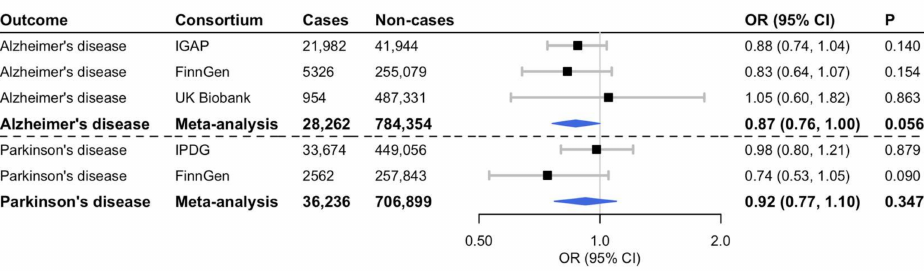
Figure 1. Associations between genetically predicted higher plasma caffeine levels and risk of Alzheimer’s and Parkinson’s disease. CI, confidence interval; OR, odds ratio. Cochran’s Q test statistic for heterogeneity between study-specific estimates: Q = 0.59 ( p = 0.74) for Alzheimer’s disease and Q = 1.73 ( p = 0.19) for Parkinson’s disease. The blue diamonds represent the combined OR estimate with its 95% CI from the meta-analysis of all studies for each